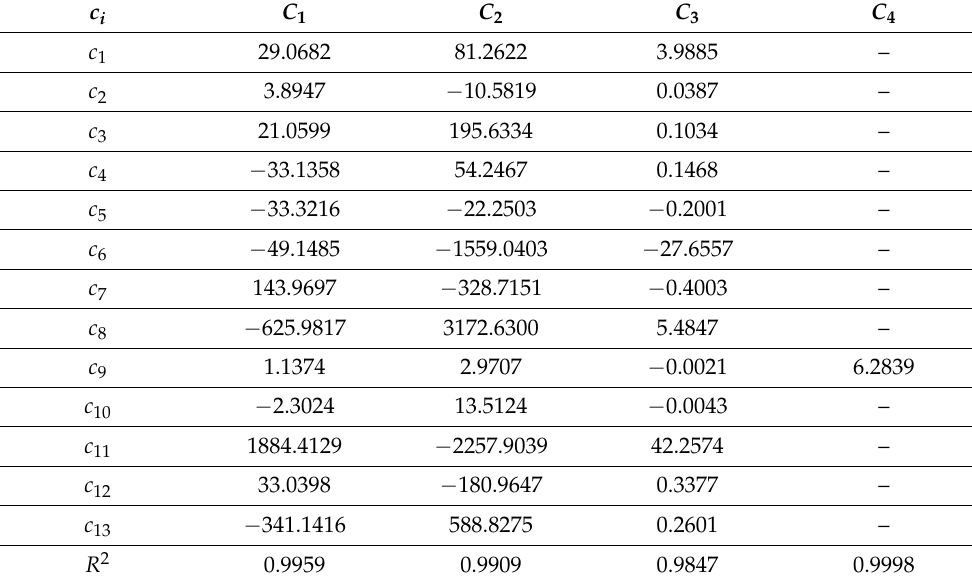
Table 4. c i coefficients and R-squared for 12-pitch-long